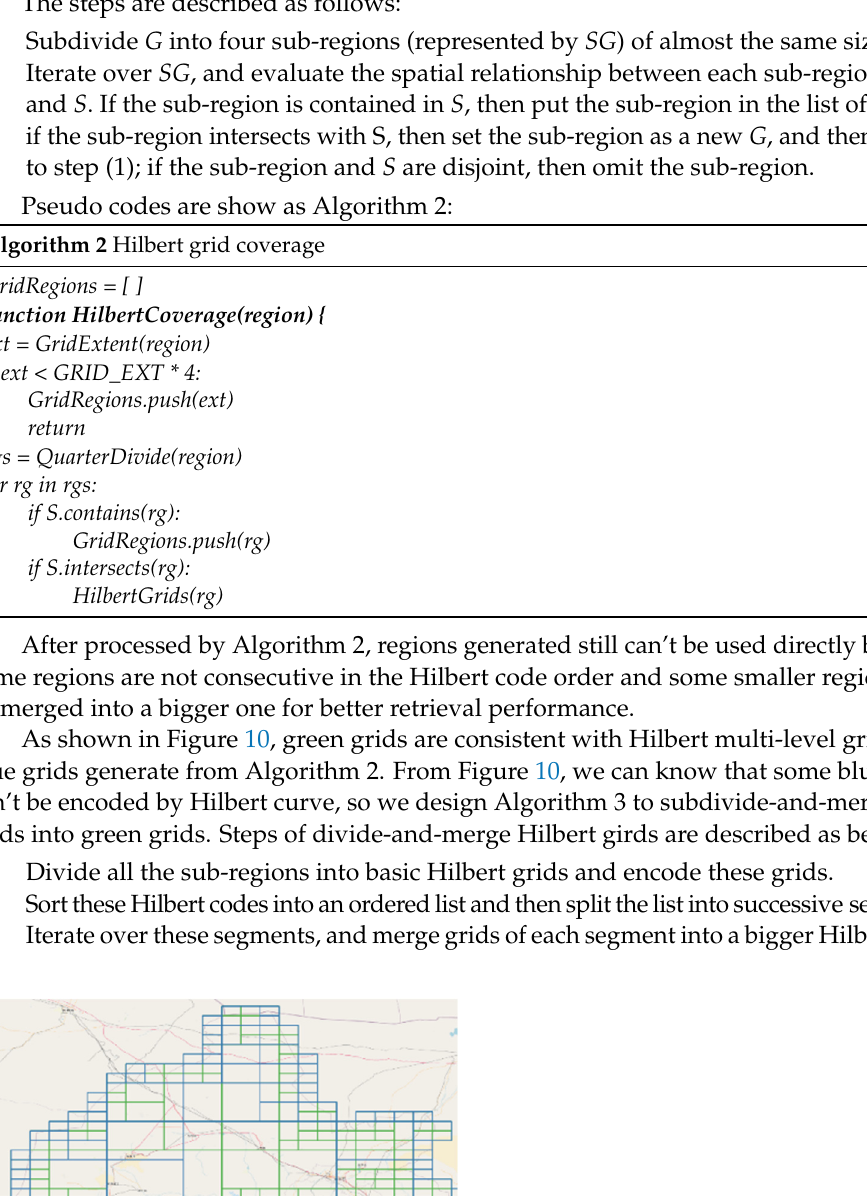
Figure 9. Relationship of S, B and G.